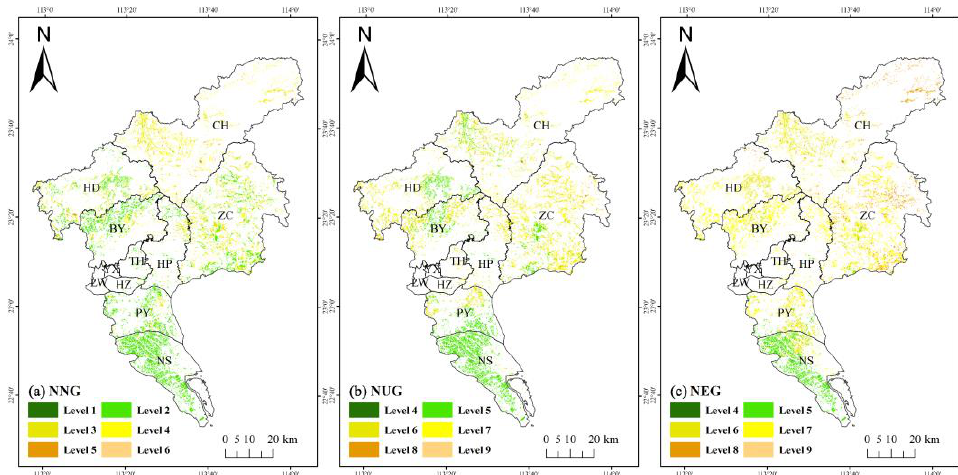
Figure 6. Classification results of cultivated land quality grade in Guangzhou in 2016.